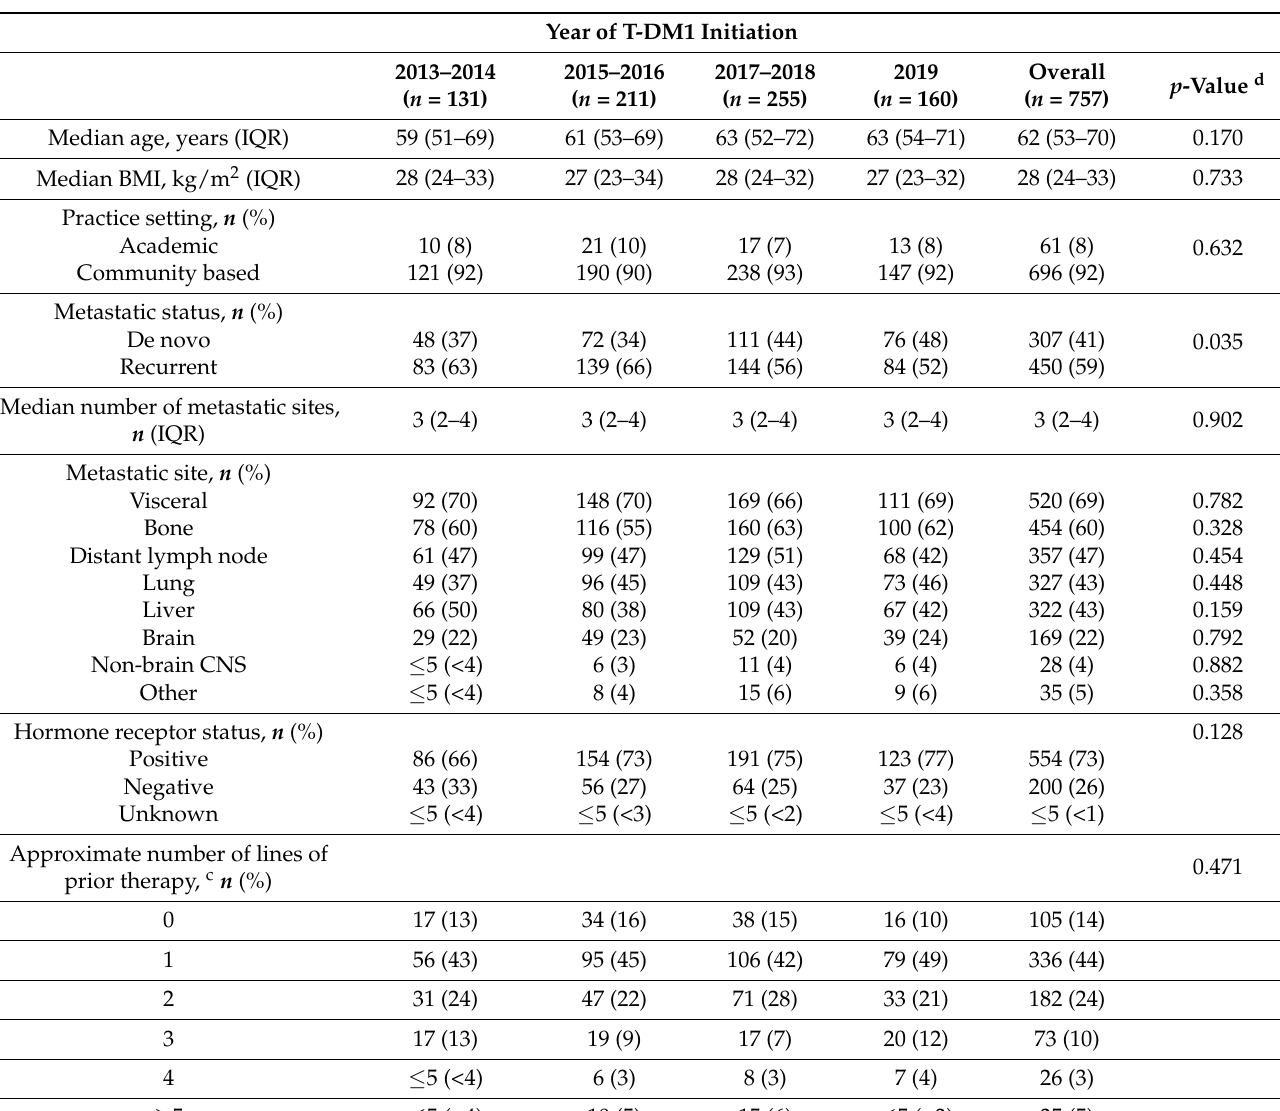
Table 1. Demographic and disease characteristics on the index date a in the primary cohort b